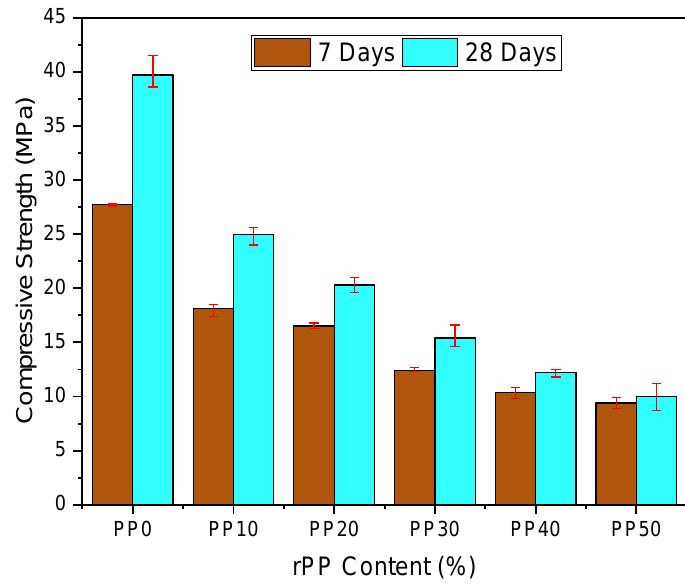
Figure 5. Compressive strength of mortar at 7 and 28 days.